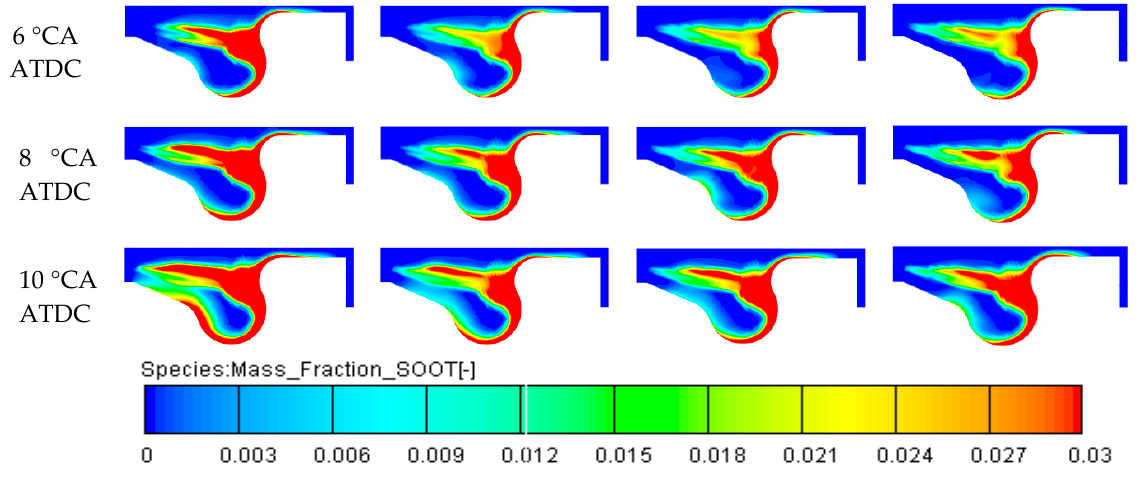
Figure 13. The soot distribution field in the cylinder.